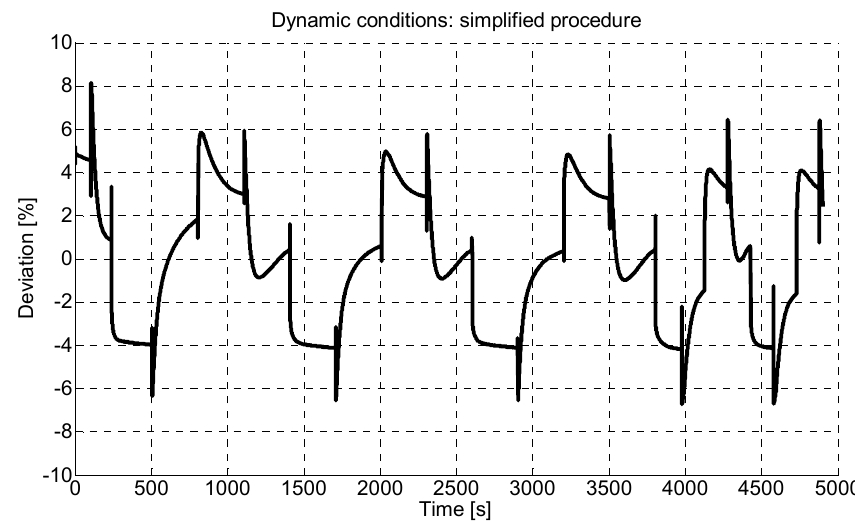
Figure 10. Test in dynamic conditions: relative deviation among measured data and model output (simplified